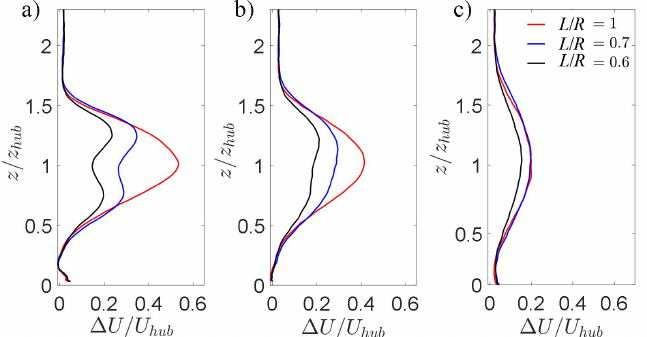
Figure 5. Profiles of the normalized streamwise velocity difference, ∆ U = U inc − U , for the turbines with rotors L / R = 0.6, 0.7 and 1 at x / d T = ( a ) 2.6, ( b ) 3.8 and ( c ) 6.